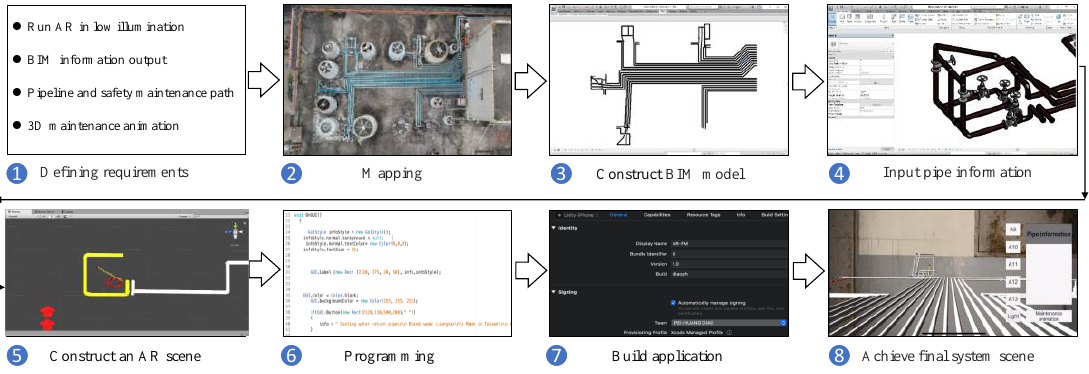
Figure 2. The development of BARMS.